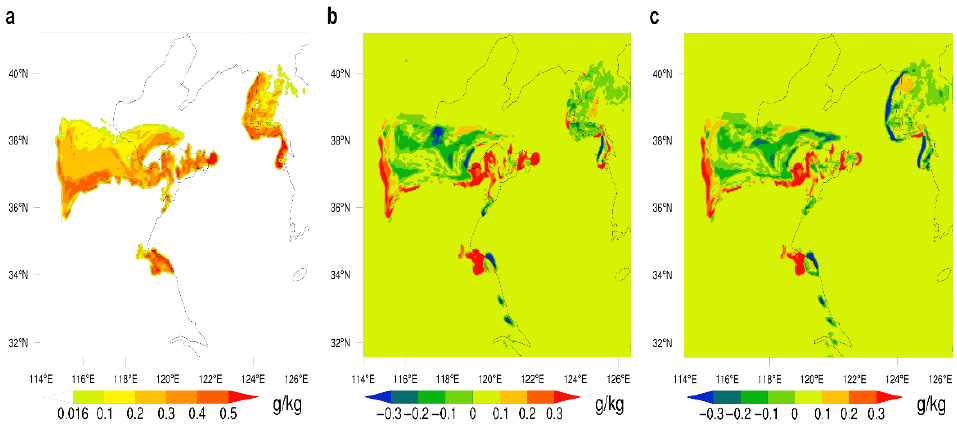
Figure 16. Liquid water content of the WRF lowest layer simulated using the 6h scheme and the difference between other schemes at 00:00 UTC on 20 February 2020. ( a ) Liquid water content of the WRF lowest layer in the 6h scheme; ( b ) difference in the liquid water content between the 6h scheme and daily scheme; ( c ) difference in the liquid water content between the 6h scheme and FNL scheme.